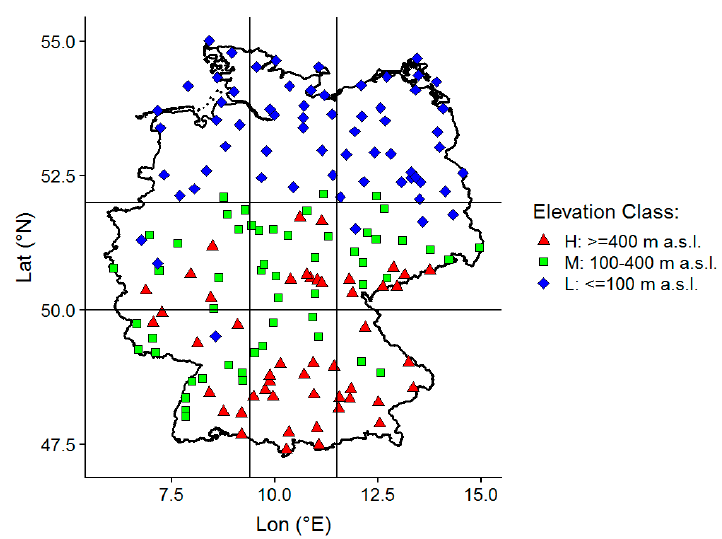
Figure 1. Geographical distribution of the meteorological stations with the corresponding elevation classes. The two horizontal lines divide the stations into northern, central, and southern stations. The vertical lines divide the stations into western, central, and eastern stations.